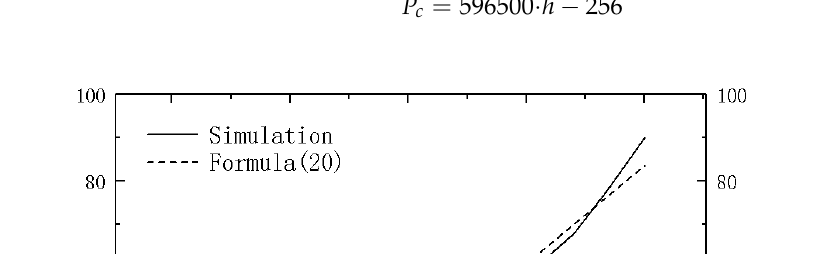
Figure 8. Curves of suction distance depending on AR from microchannel and porous media mod- els.